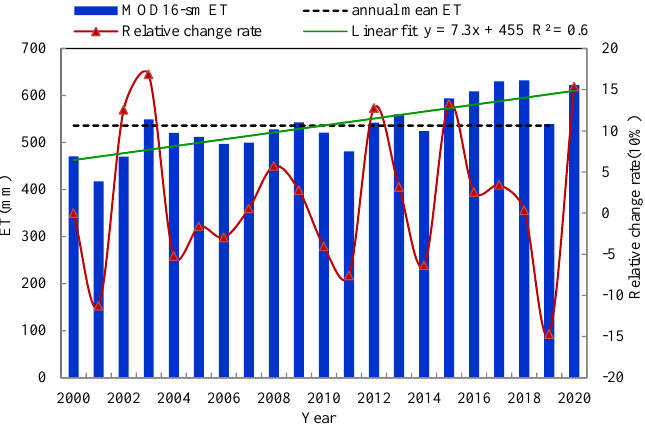
Figure 5. Inter-annual variations of ET in the study area from 2000 to 2020.